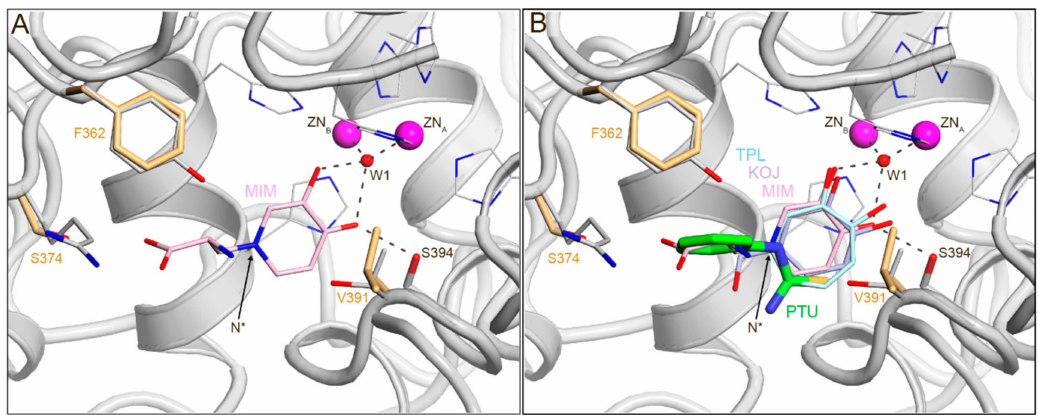
Figure 3. PTU binds in the active site of TYRP1-3M with its aromatic ring pointing outwards from the binuclear metal center, whereas the other inhibitors point inwards. ( A ) Binding of the L-DOPA analogue mimosine (cartoon atoms colored in light pink; PDB 5M8R); N* indicates the position of the nitrogen atom in the aromatic ring of mimosine. ( B ) Superimposition of TYRP1-3M with bound mimosine (MIM, light pink; PDB 5M8R), tropolone (TPL, light blue; PDB 5M8T), kojic acid (KOJ, gray; PDB 5M8Q), and PTU (PTU, green; PDB 5M8S). MIM, TPL, and KOJ bind with their aromatic ring pointing inwards, towards the binuclear metal site. PTU binds outward with its aromatic ring. In the figure, oxygen atoms are colored in red, and nitrogen atoms in blue; zinc atoms are labeled as ZN A and ZN B ; W1 is the bridging water molecule between ZnA and